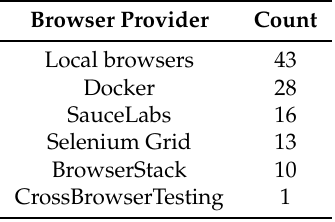
Table A11. 4.b. Which browser provider do you use for your Selenium tests?